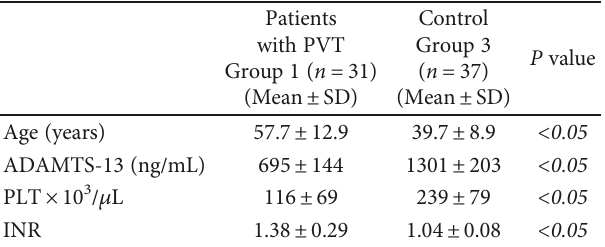
Table 3: Comparison of the analyzed markers in group 1 (with PVT) and group 3 (healthy volunteers).